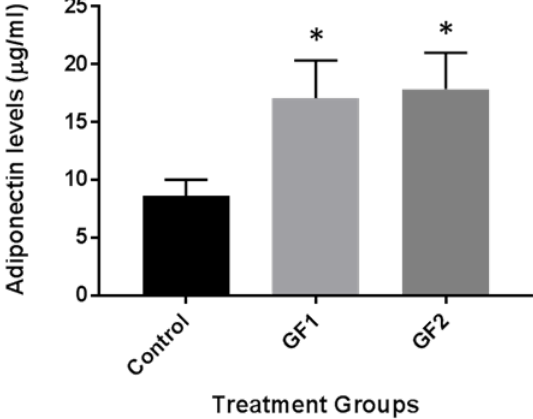
Figure 5. The effect of GF diets on the exercise signaling pathways and autophagy. The expression of GF/exercise-associated adiponectin levels were evaluated by ELISA. Mice that were fed control or GF diets were evaluated for adiponectin levels. The results are expressed as mean ± SD ( n = 10 per group), * p < 0.01 compared to the control group.